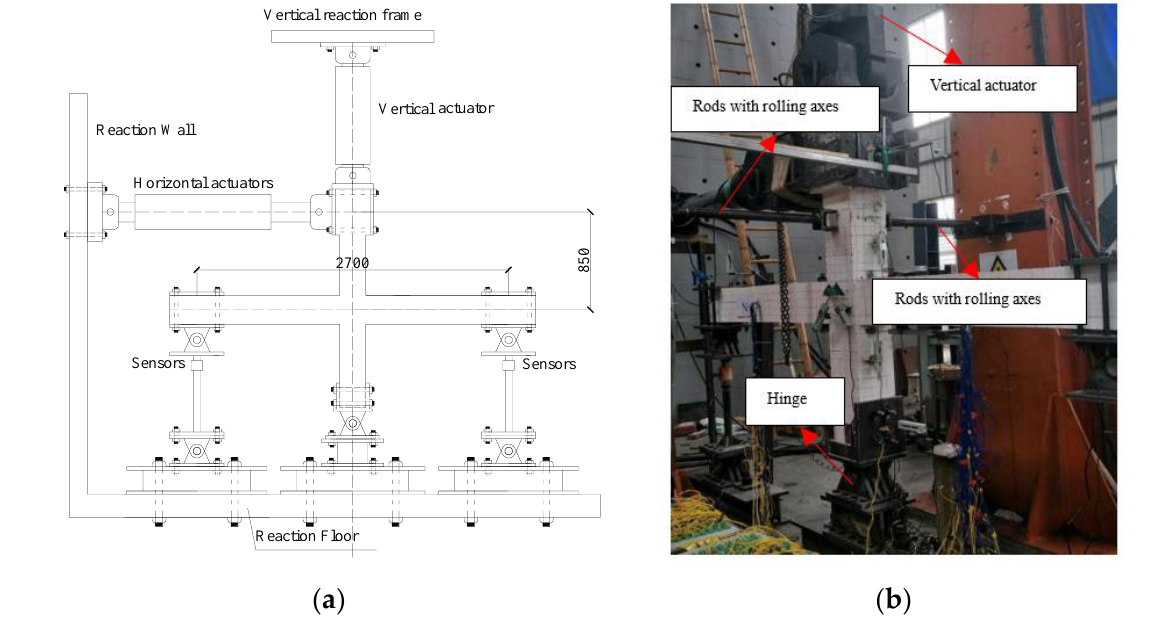
Figure 4. Loading setup. ( a ) Loading setup; ( b ) Photo of setup.